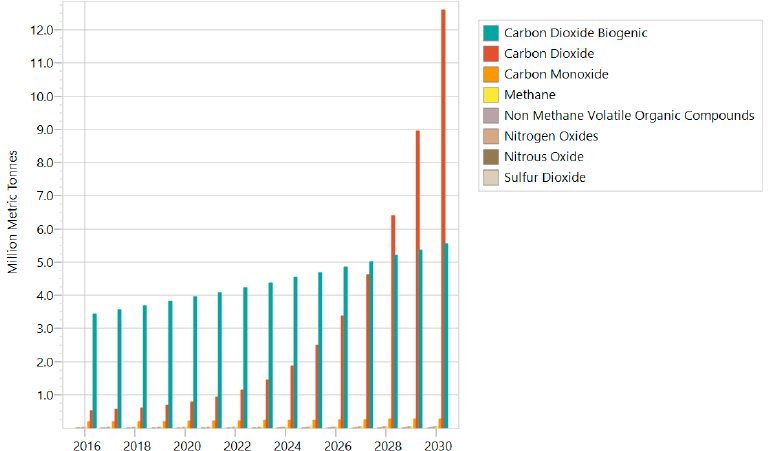
Figure 21. Emissions under LPG and improved stoves scenario.